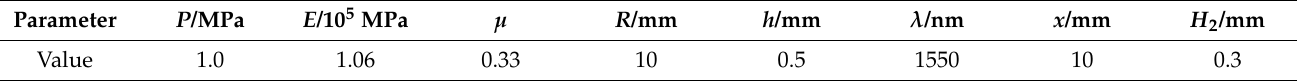
Table 2. The specific parameters of the sensor.